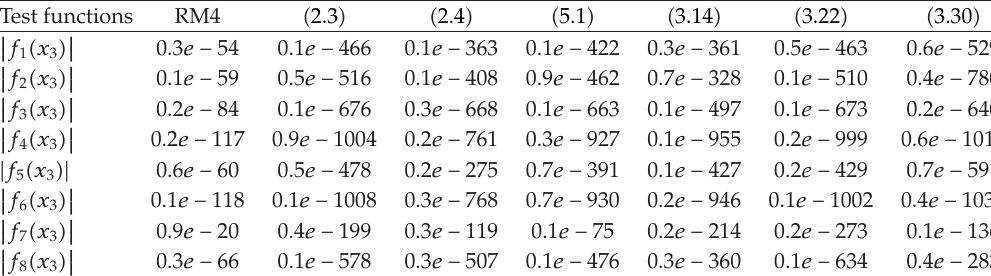
Table 4: Results of comparisons for di ff erent methods after three full iterations. Test functions